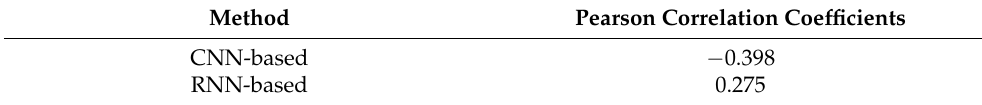
Table 6. Pearson correlation coefficients of CNN-based feature extractor and RNN-based feature extractor.